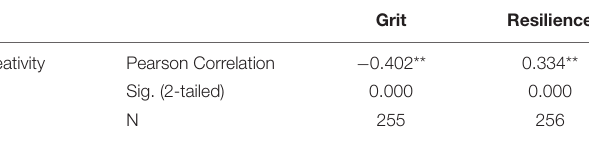
TABLE 8 | Correlations between creativity and the